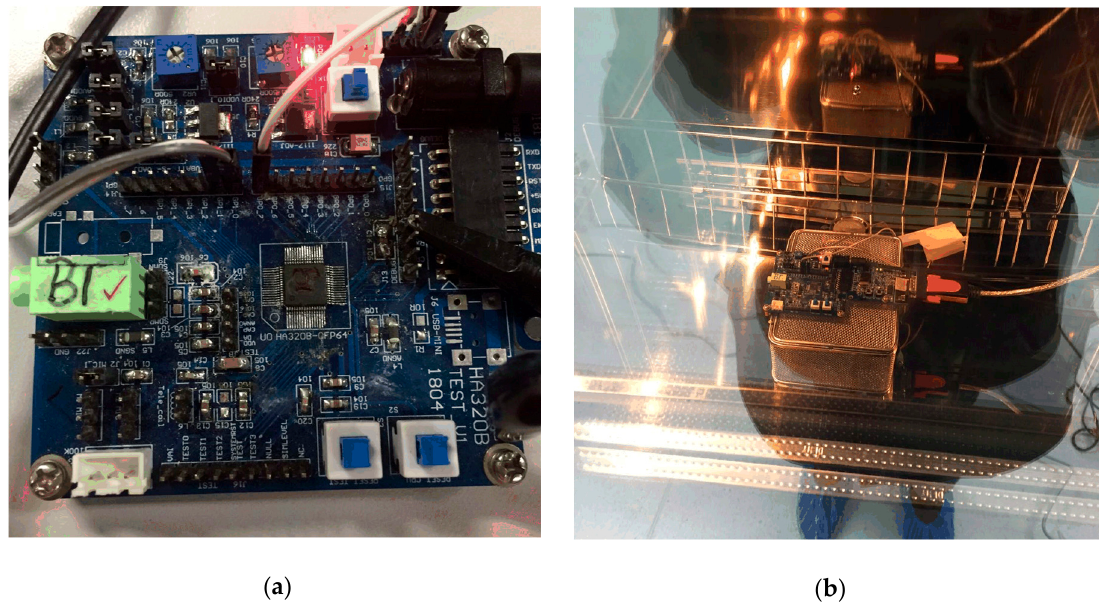
Figure 8. Experiment setup: ( a ) the PCB used to the test the sensor in the SoC in a QFP64 package; ( b ) the measurement PCB in the chamber.